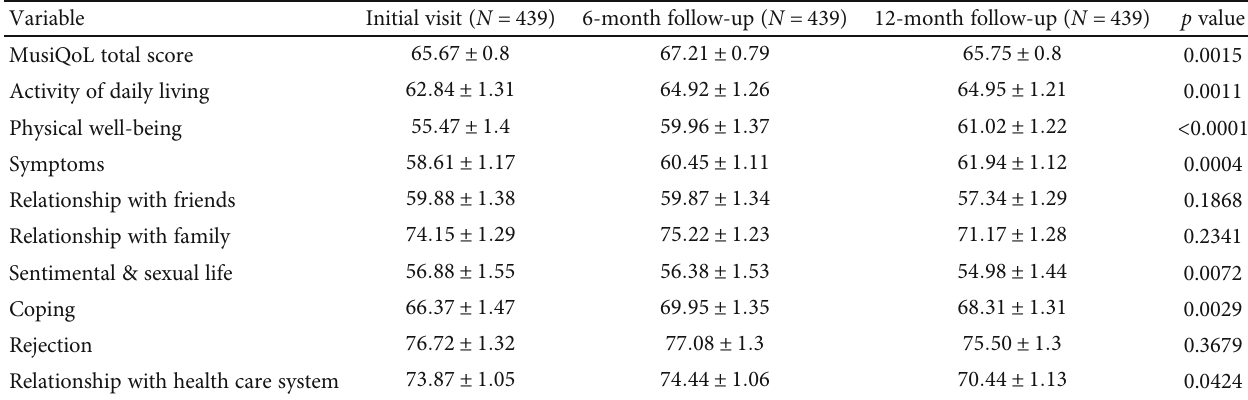
Table 2: Overall and domain-speci fi c MusiQoL scores over time.